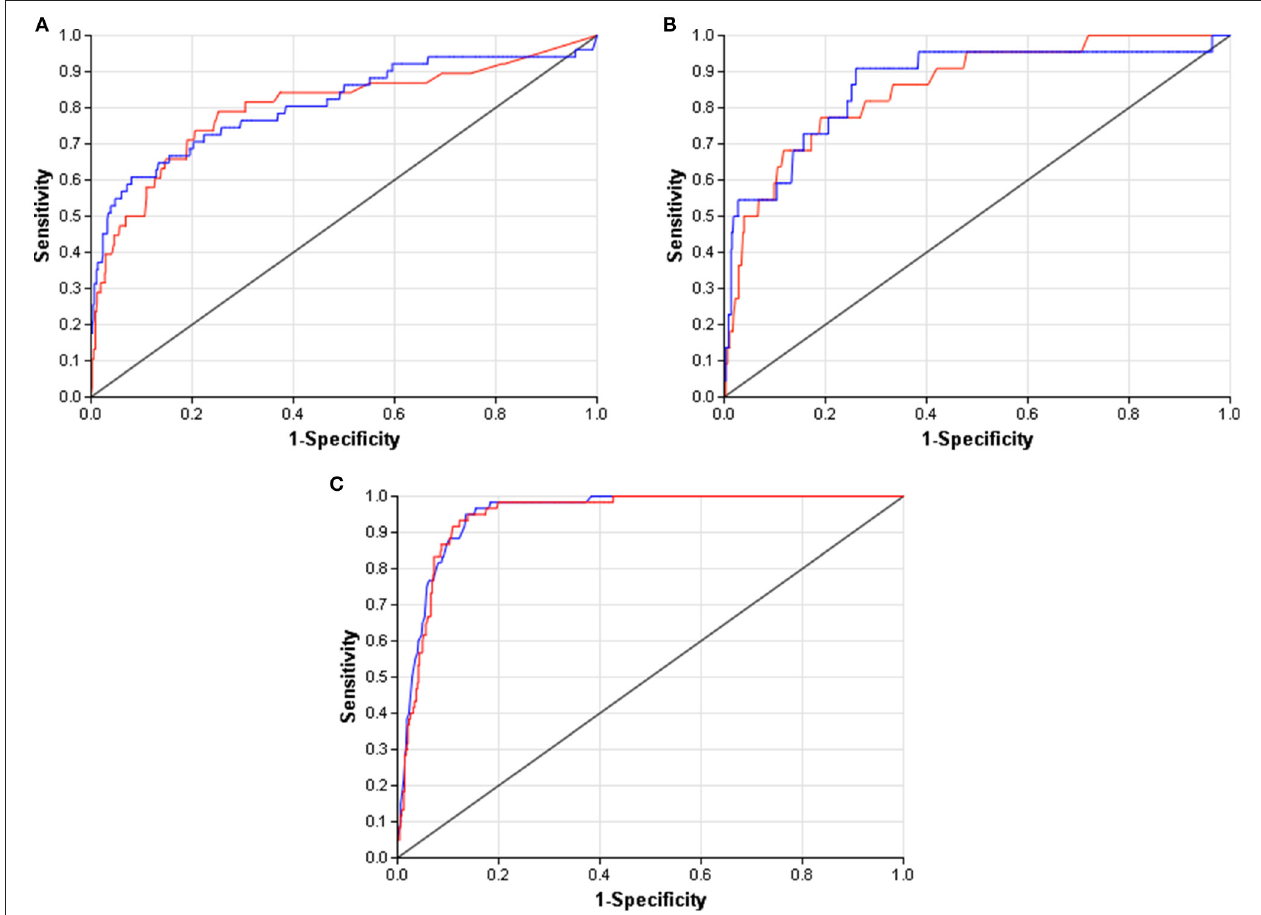
FIGURE 8 | ROC curves of best models (blue) and selected Dmlab models ranked 2–10th (red). (A) SR-ATAD5. (B) SR-MMP. (C)